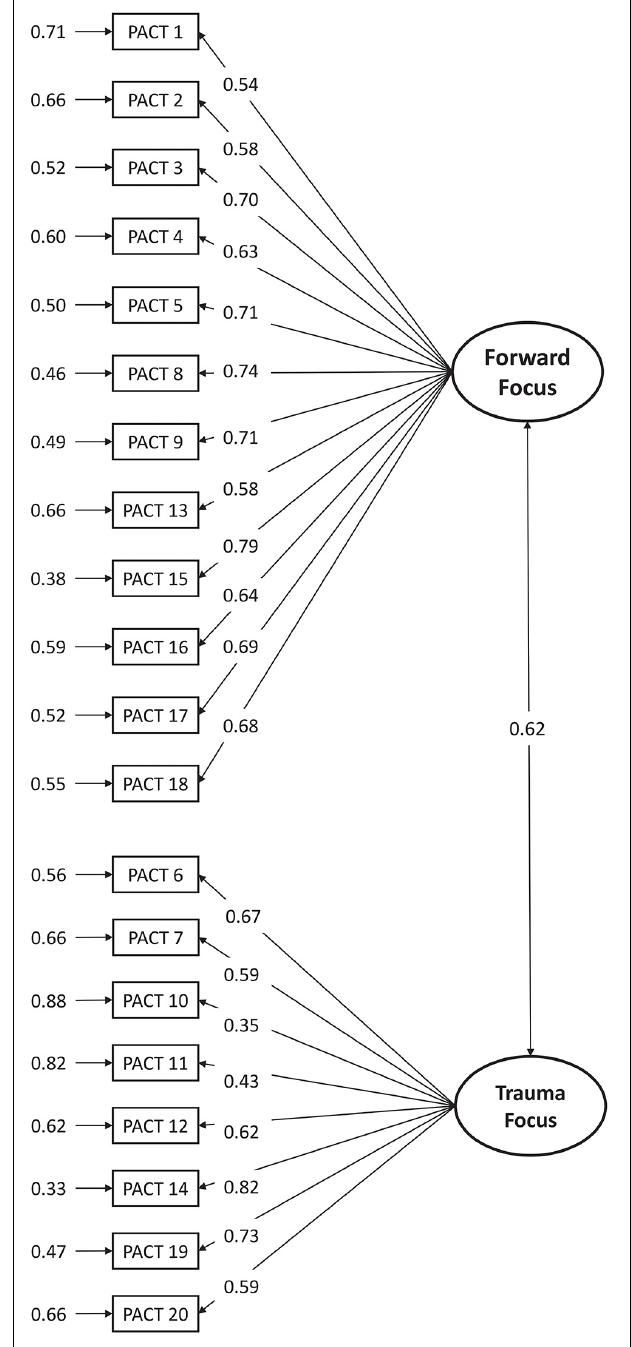
FIGURE 2 | Confirmatory factor analysis of the two-factor model of the PACT. Standardized coefficients and measurement errors are shown.